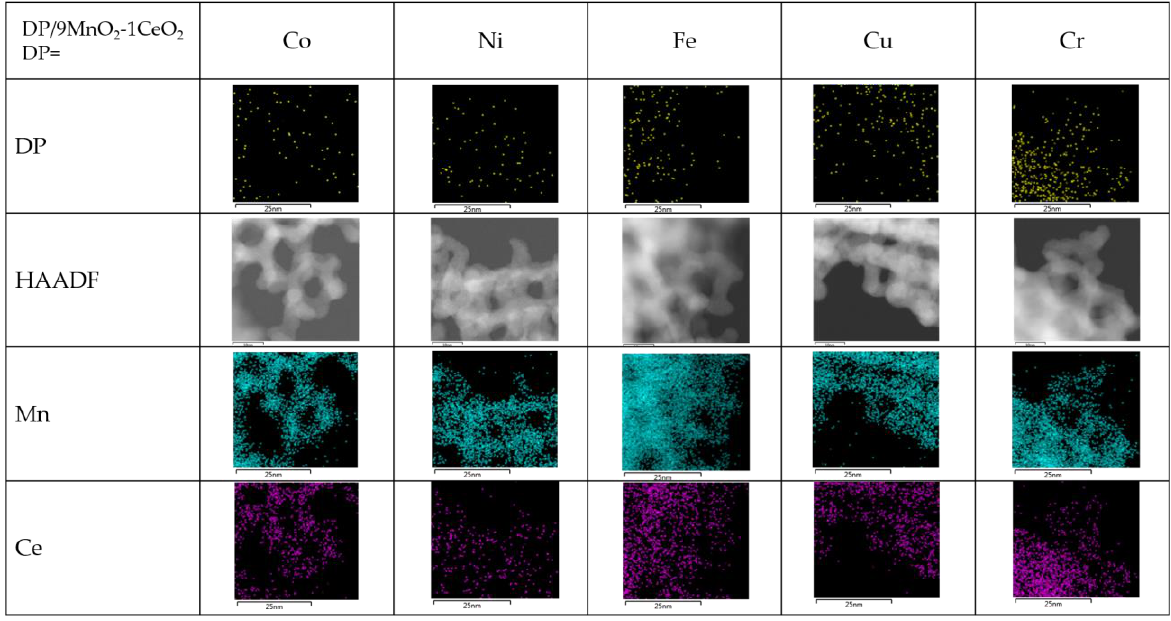
Figure 5. TEM images and EDS elemental mapping of DP/9MnO 2 – 1CeO 2 catalysts.